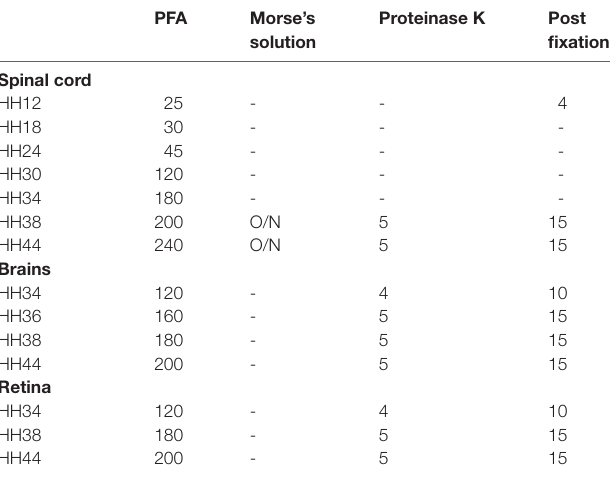
TABLE 1 | Age-dependent treatment of tissue sections for in situ